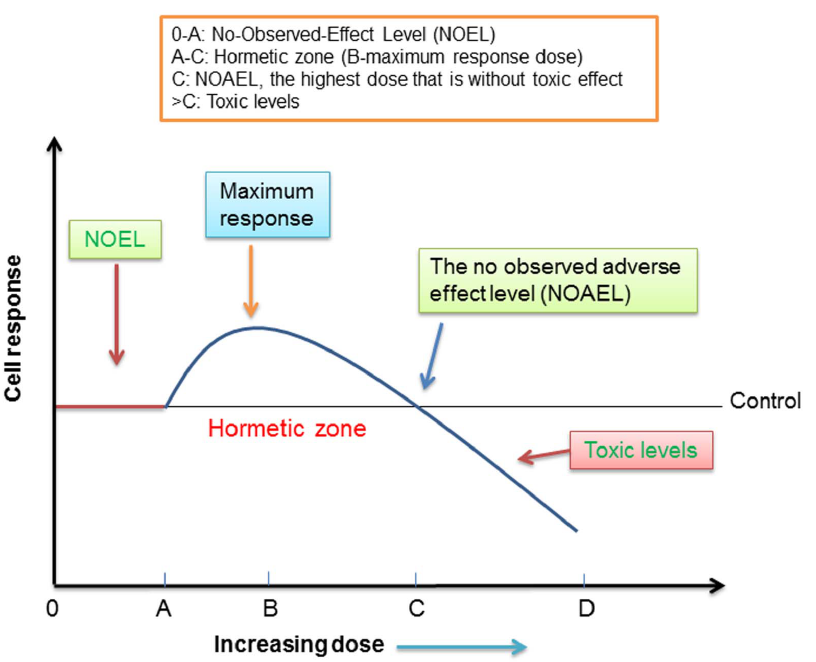
Fig. 6. A schematic diagram on the hormetic effect of ITCs. For all cell types, dosage range 0-A is safe. In the majority of diets, the intakes of hormetic phytochemicals are likely to fall within this safe range. For normal cells, dose B could be used promote new blood vessel formation or promote wound healing; doses . C are toxic. For tumour cells, doses between A and C should be avoided; and doses . C to D could be used for